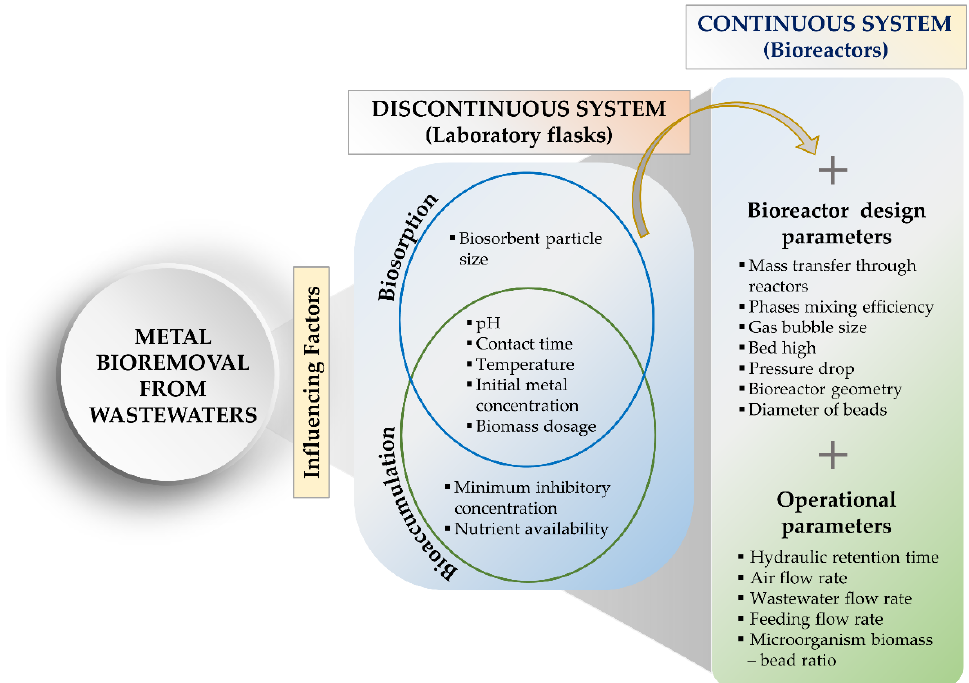
Figure 1. Influencing factors of biosorption and bioaccumulation processes applied in discontinuous and continuous systems.